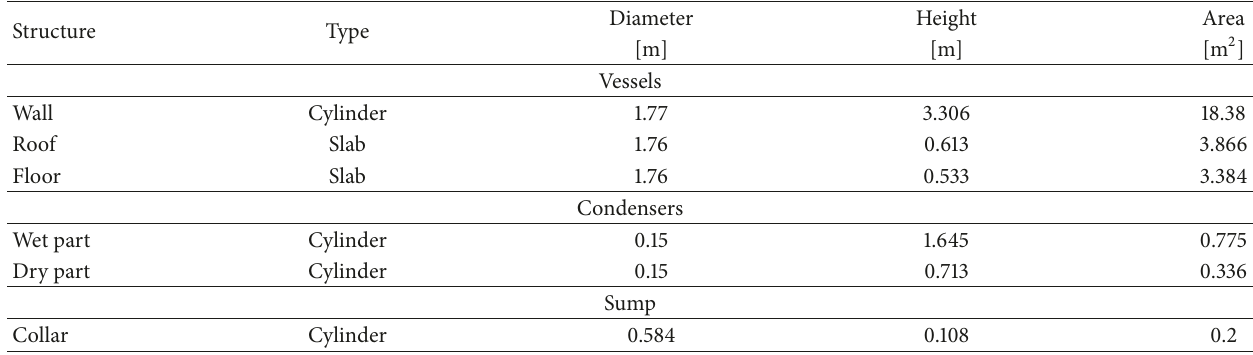
Table 2: Design parameters of the Ph´ebus FPT experiment [5].